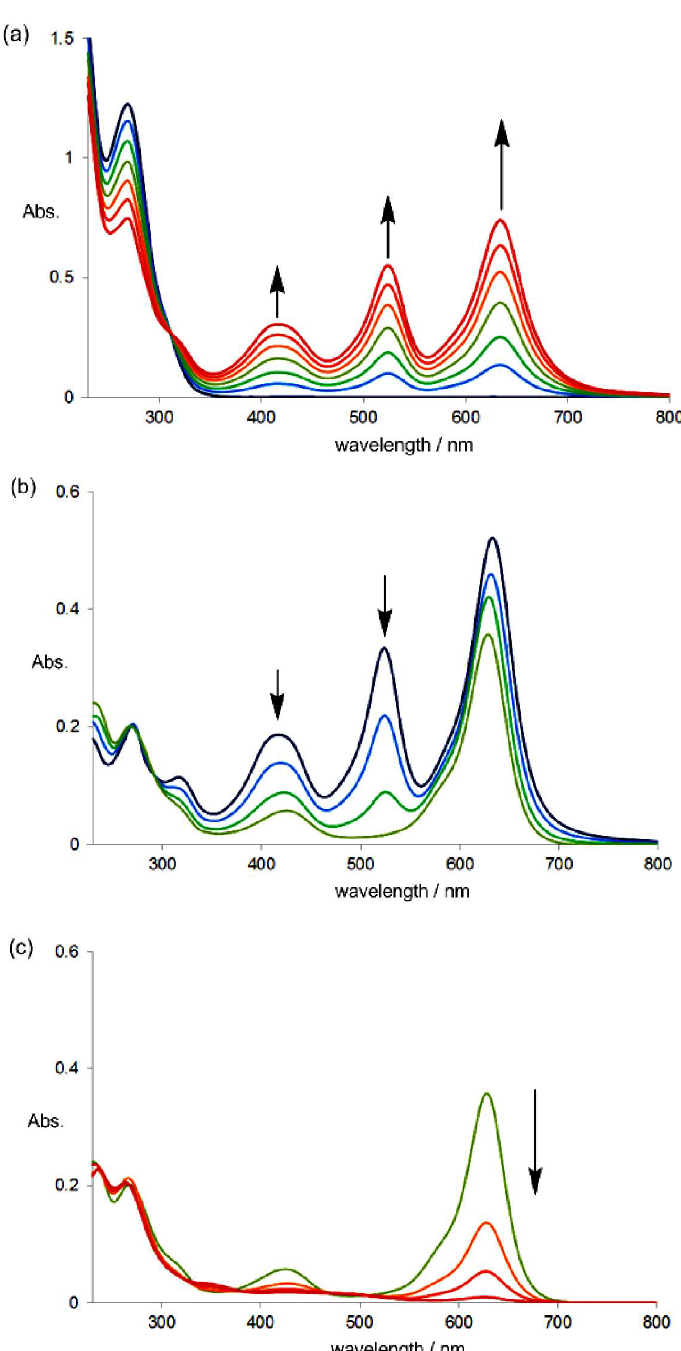
Figure 4. Changes in the UV–VIS spectra of ( a ) 1NO (3.5 mL; 3.0 × 10  5 M in CH containing 0.05 M Bu and 2NO 2+ (3.5 mL soln; 6.2 × 10 −6 M in CH electrochemical reduction (40 μA): ( b ) stage 1, at 2-min intervals; ( c ) stage 2, at 8-min